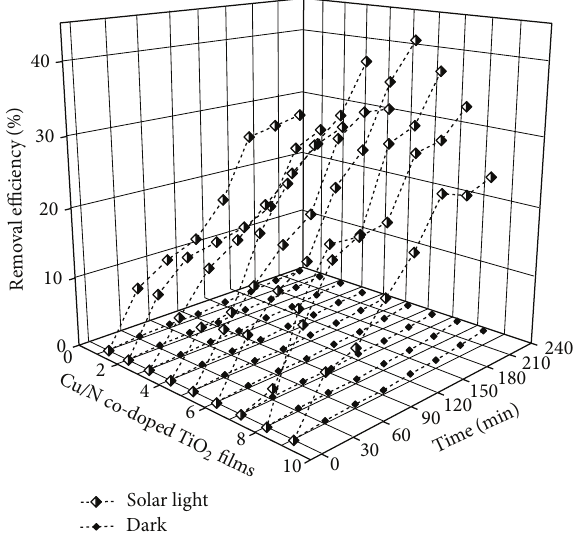
Figure 8: Removal efficiency curves of humic acid over 2 :3 Cu/N codoped TiO 2 film by